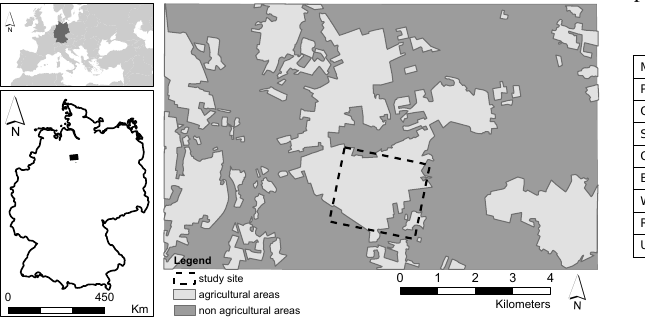
Figure 3. Phenology stages of crops considered for